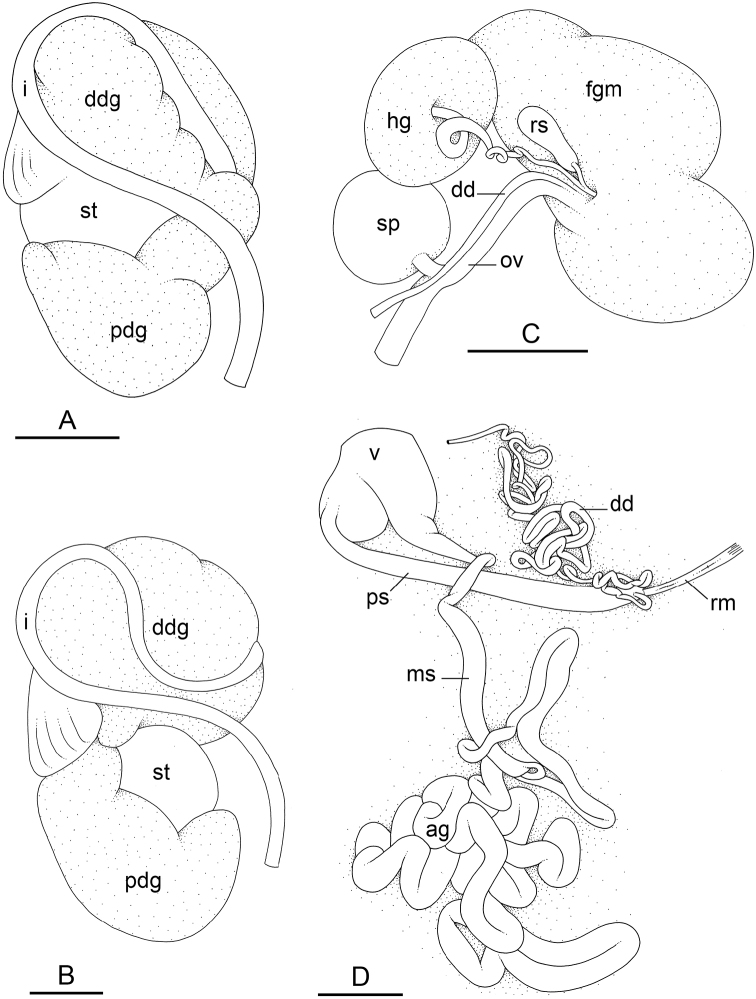
Peronia
setoensis, Japan, Honshu A [3753] (NSMT-Mo 78987) B–D holotype [5383 H] (NSMT-Mo 78985) A digestive system, dorsal view, with intestinal loops of type V B digestive system, dorsal view, with intestinal loops of type V C posterior, hermaphroditic (female) reproductive system D anterior, male, copulatory apparatus. Scale bars: 2 mm (A–D). Abbreviations: ag accessory penial gland, dd deferent duct, ddg dorsal digestive gland, fgm female gland mass, hg hermaphroditic gland, i intestine, ms muscular sac, ov oviduct, pdg posterior digestive gland, ps penial sheath, rm retractor muscle, rs receptaculum seminis, sp spermatheca, st stomach, v vestibule.